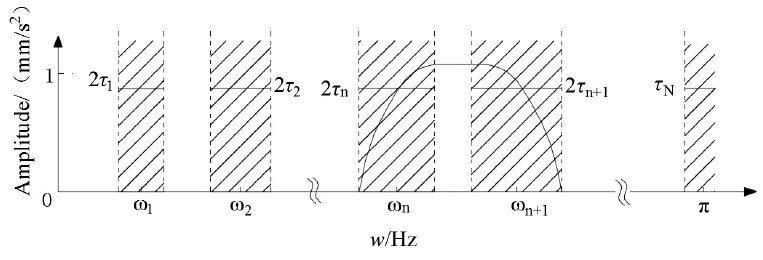
Figure 1. Region segmentation diagram of the Fourier axis.